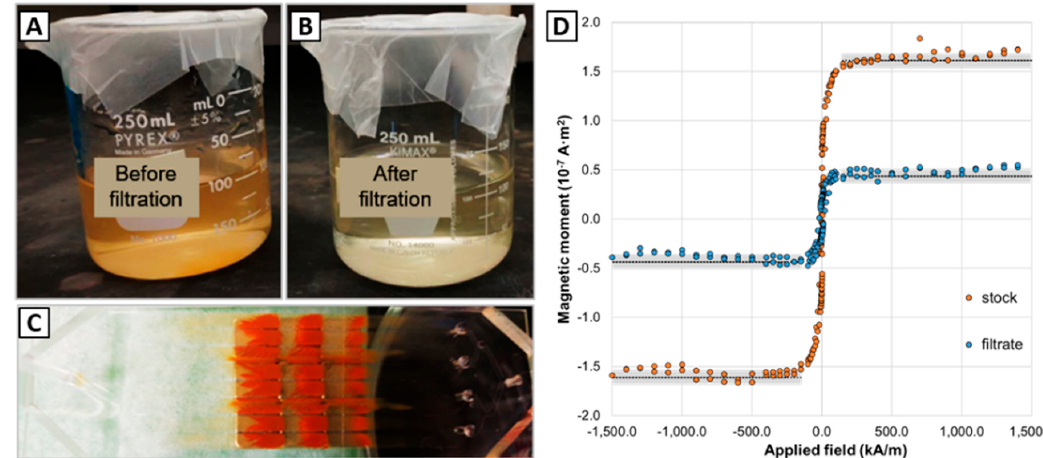
Figure 7. ( A , B ) 100 mL sample comparison: before filtration, after filtration, ( C ) IONs captured in the magnetic separation microfluidic device, and ( D ) vibrating sample magnetometer data corresponding to 300 µ L dried droplet on a substrate from the 100 mL sample filtered using the µFMS device at 120 µL/s. In panel ( D ), black dashed lines represent the average value from the saturation magnetic moment measured and the gray bands represent ± one standard deviation.